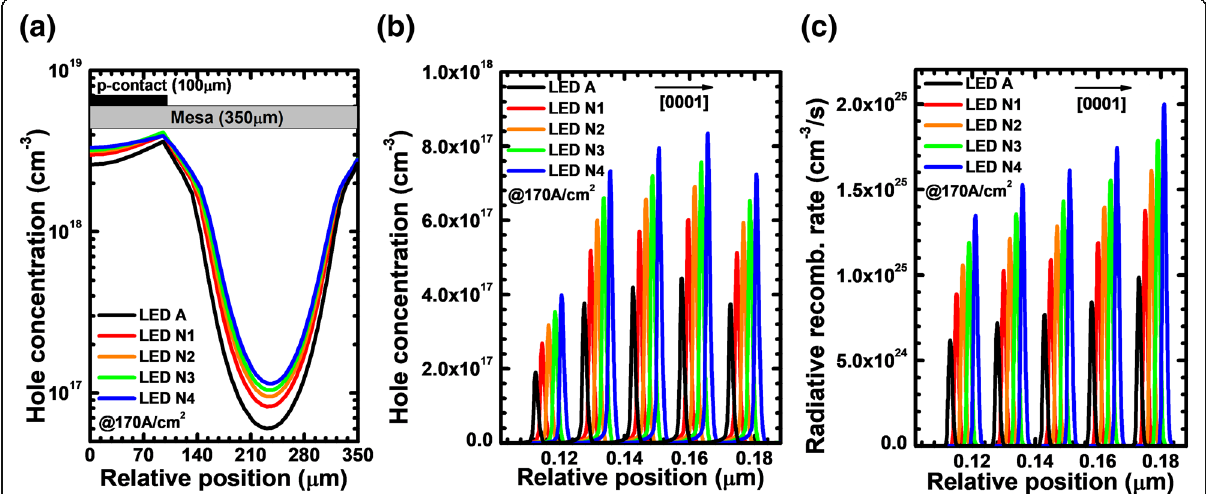
Fig. 12 a Lateral hole distribution in the last quantum well, b hole concentration profiles, and c radiative recombination rate profiles in the MQW region for LEDs A, N1, N2, N3, and N4 at the current density of 170 A/cm 2 . The plotted curves for panels b and c are purposely shifted by 2 nm for better resolution